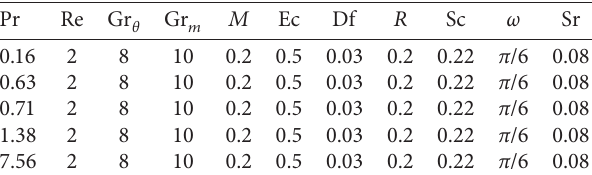
Table 1: Values of the change in Prandtl number.